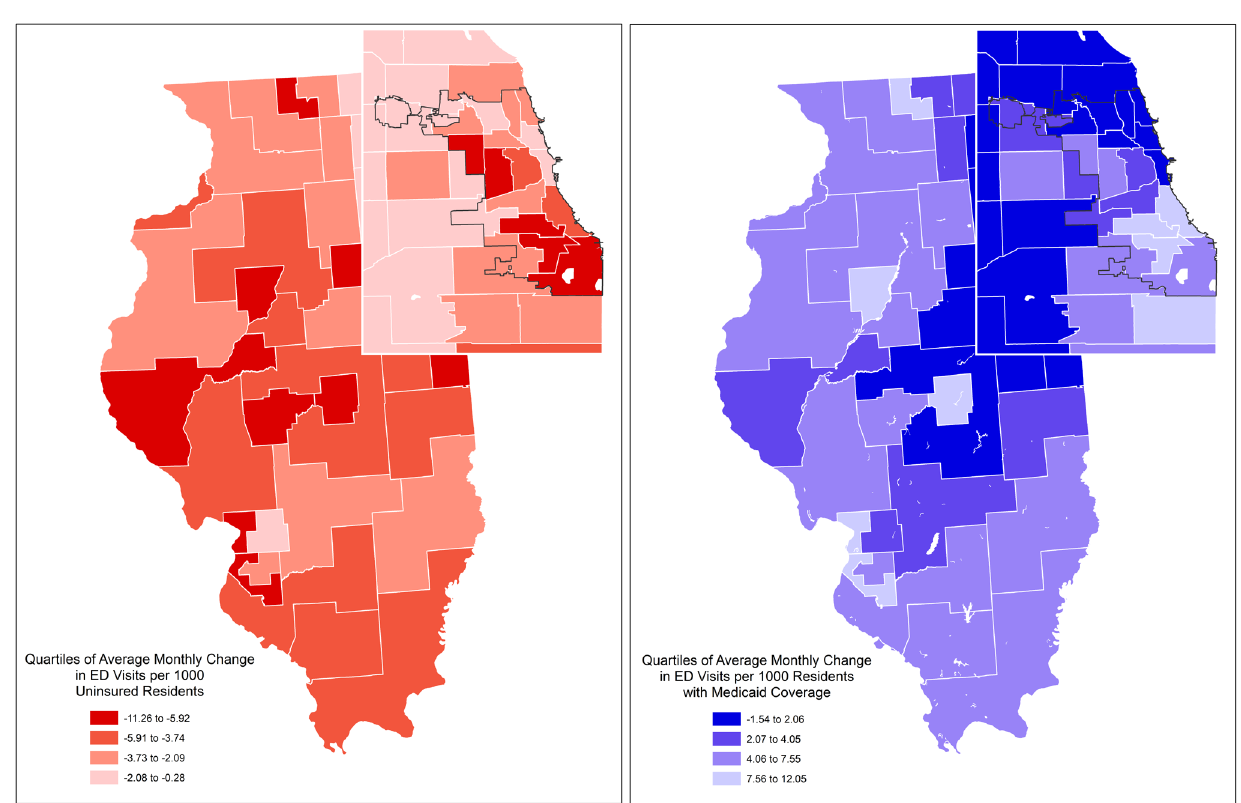
Figure 3. Quartiles of change in emergency department (ED) visits per 1,000 residents age 18-64 (A) uninsured or (B) with Medicaid coverage across 88 Illinois public use micro